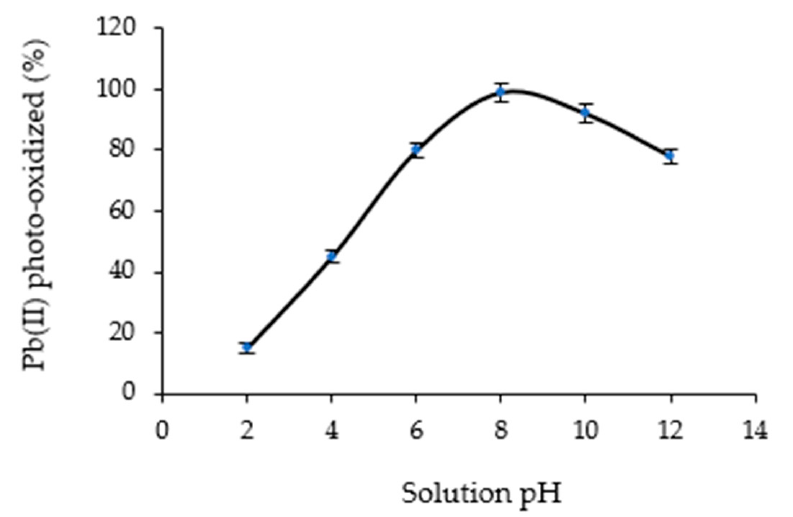
Figure 8. The influence of solution pH on the Pb(II) photo-oxidation (photocatalyst weigh = 15 mg, volume of Pb(II) solution = 25 mL, Pb(II) concentration = 15 mg/L and reaction time = 30 min). In the solution with low pH, the surface of TiO 2 was protonated to form positive charge (TiO 2 H + ), inhibiting the OH radicals formation [8,12,14,23]. On the other side, the cationic of Pb 2+ was formed predominantly in the solution [7,8], which repulsed the adsorption of Pb 2+ on the surface of the protonated N-doped TiO 2 . These simultaneous conditions led to less effective photo-oxidation. When the pH was gradually increased up to 8, the protonation of TiO 2 gradually depleted, which generated a greater amount of OH radicals. In such a pH range, a large number of Pb 2+ were available [7,8], enabling it to interact with TiO 2 surface effectively. This condition was very conducive to reaching high photo-oxidation. At pH higher than 8 (base condition), the surface of TiO 2 was found as anionic TiO - species that were inhibited to release OH radicals [8,12,14,23]. In the base solution, Pb(OH) 2 precipitate was formed [7,8], which constrained the light penetration, consequently limiting the photocatalyst to produce the OH radicals. The lower number of OH radicals available and the presence of the precipitate explained the significant decline of the photo-oxidation. From the data, it is found that the most effective process took place at neutral pH and has the potential to be applied on an industrial